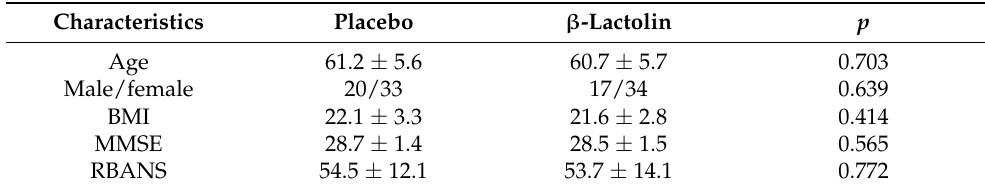
Table 1. Subject characteristics at baseline.